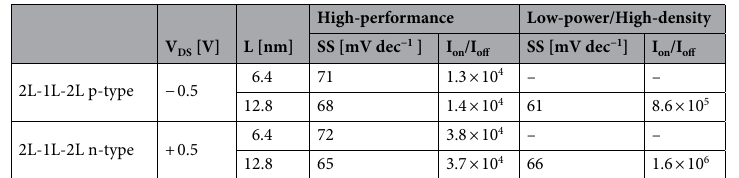
Table 1. Figures of merit for 2L-1L PtSe 2 FETs. All figures of merit were obtained by mapping E on-site from DFT. The IV curves from which the data were extracted are available in Supplementary Figure